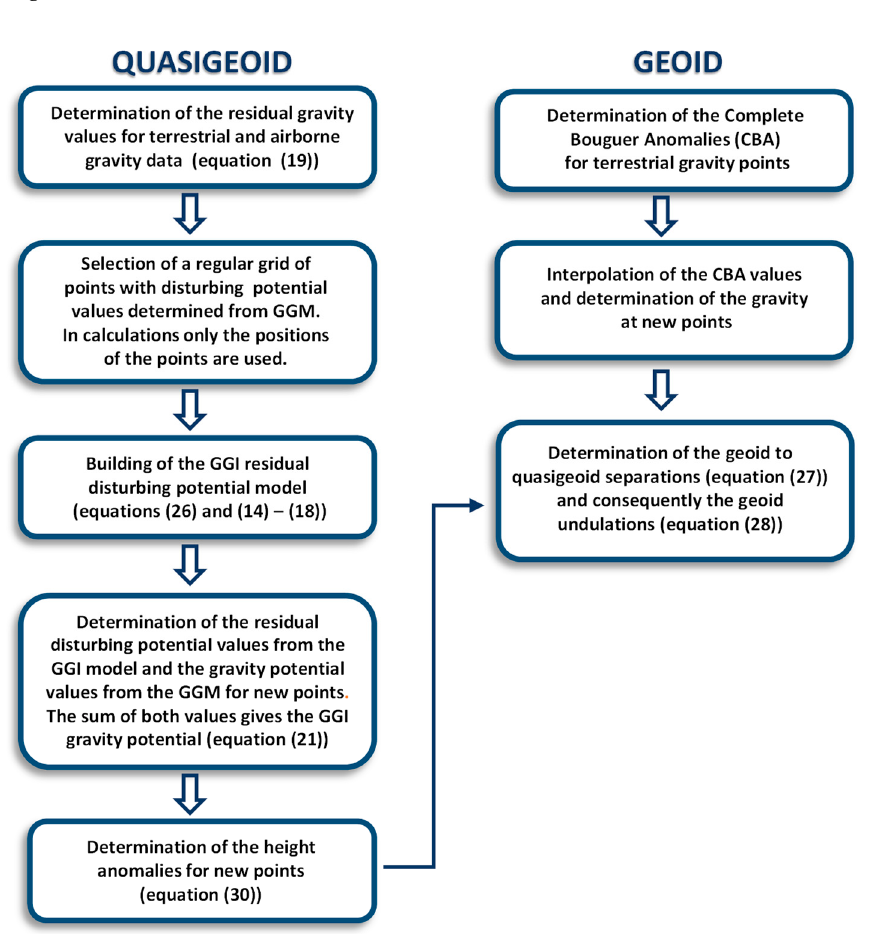
Figure 4. Stages of the geoid and quasigeoid model determination.